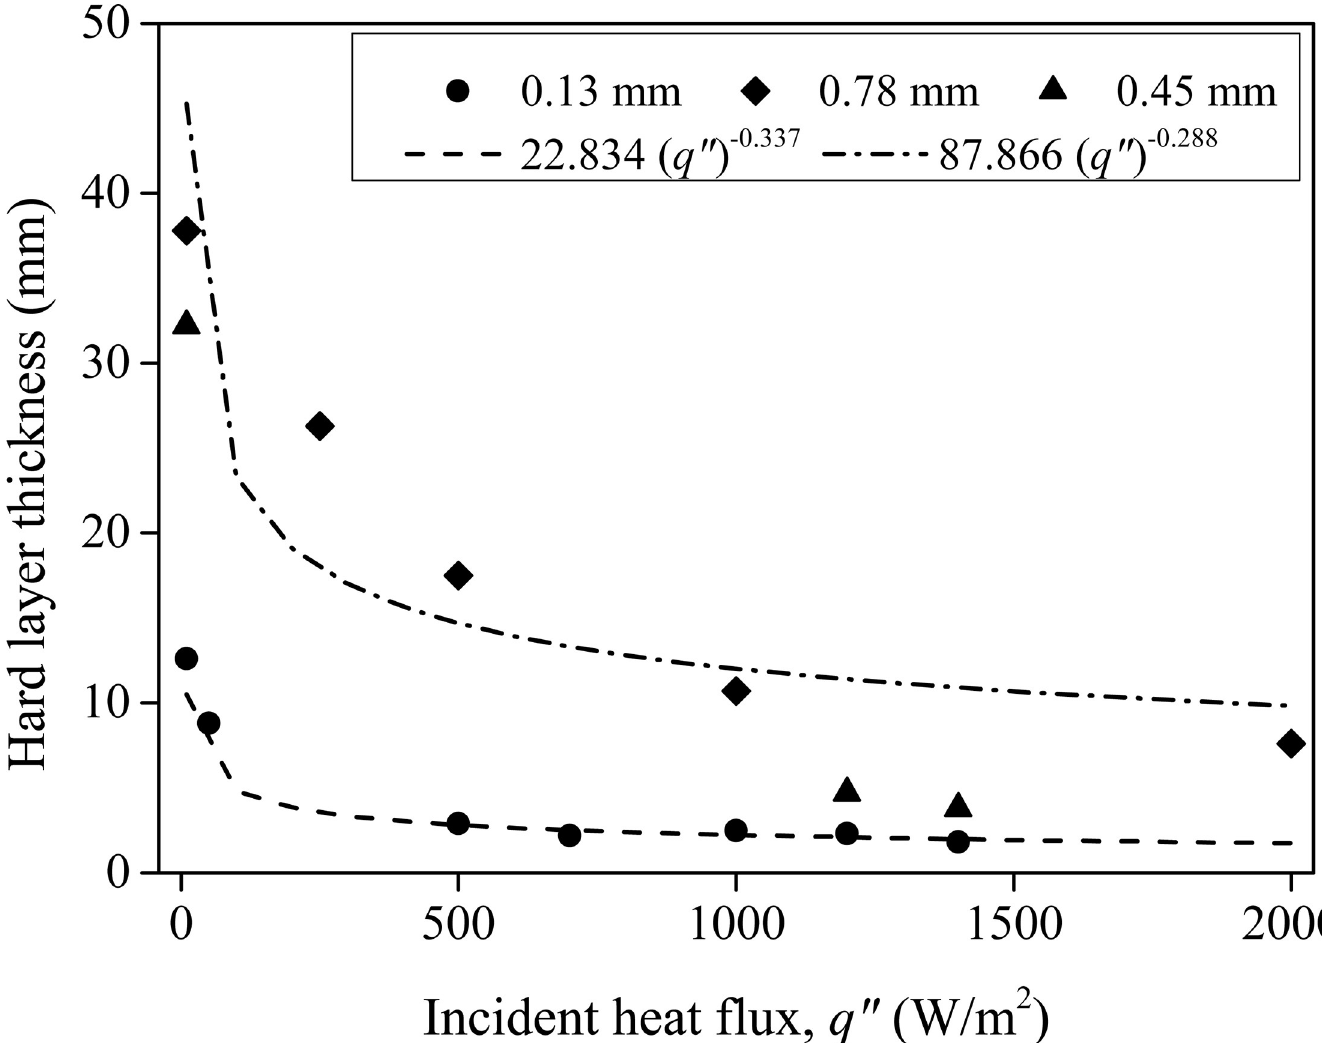
Fig 9. Variation of the thickness of the near-surface hard layer formed in different experiments as a function of the particle sizes and the incident heat fluxes. The data shown here is only for the hydrophilic